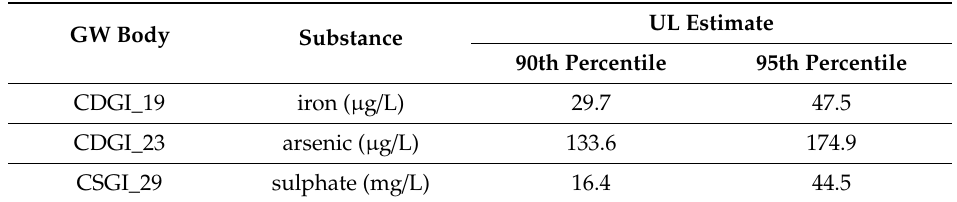
Table 9. Comparison of 90th and 95th percentile UL estimates for pre-selected data sets of arsenic (As), iron (Fe), and sulphate (SO 4 ) for three groundwater